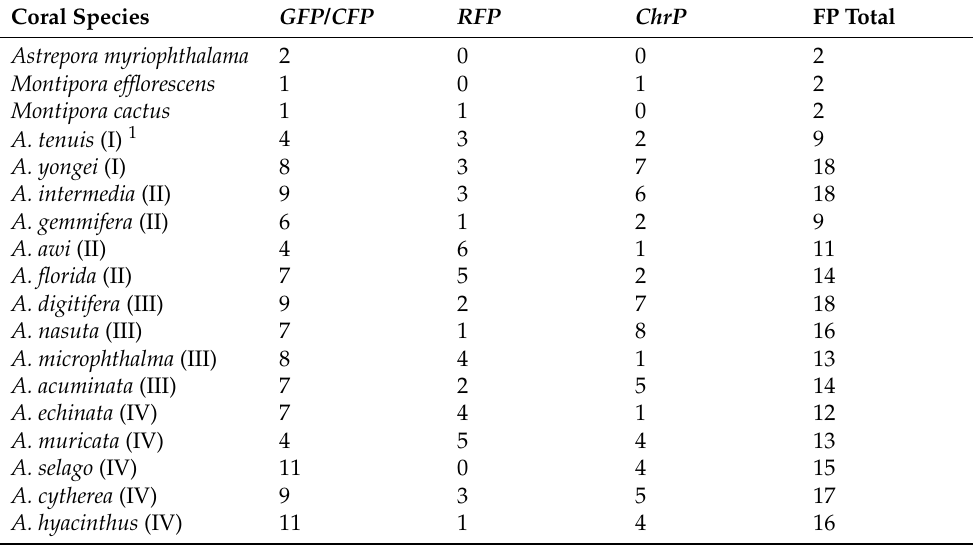
Table 2. The number of complete fluorescent protein (FP) candidate genes in acroporid coral genomes. Coral Species GFP/CFP RFP ChrP FP Total Astrepora